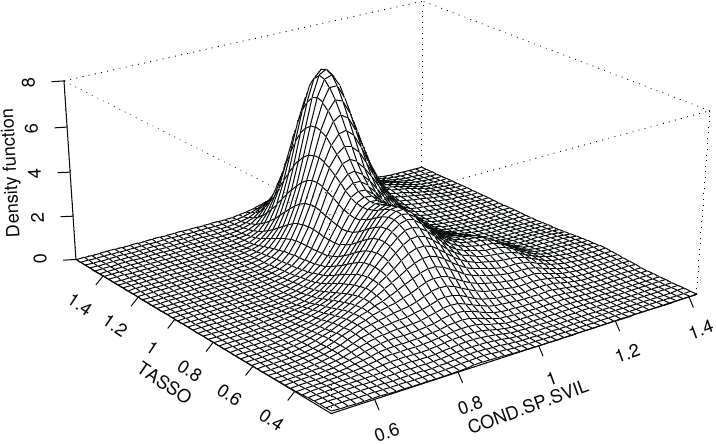
Figura 9 – Evoluzione da non condizionata a condizionata a spillover e sviluppo strutturale